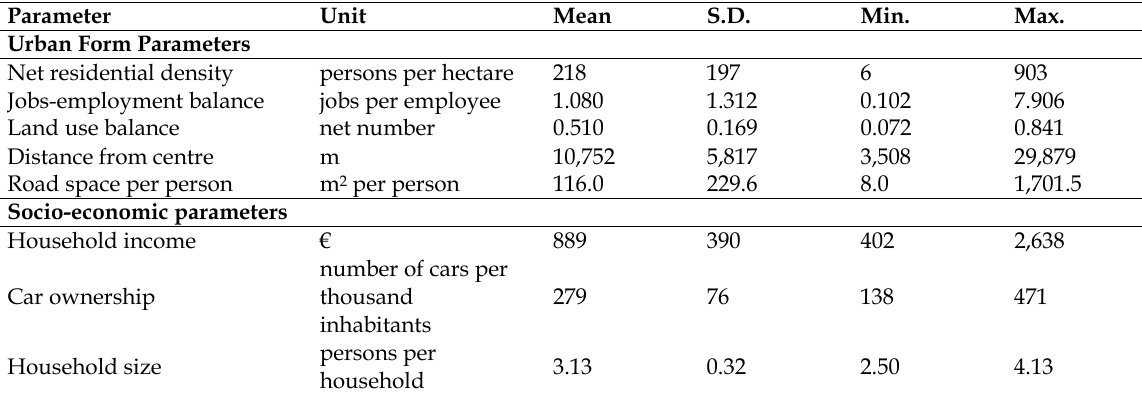
Table 2. Descriptive statistics of urban form and socio-economic parameters Parameter Unit Mean S.D. Min.